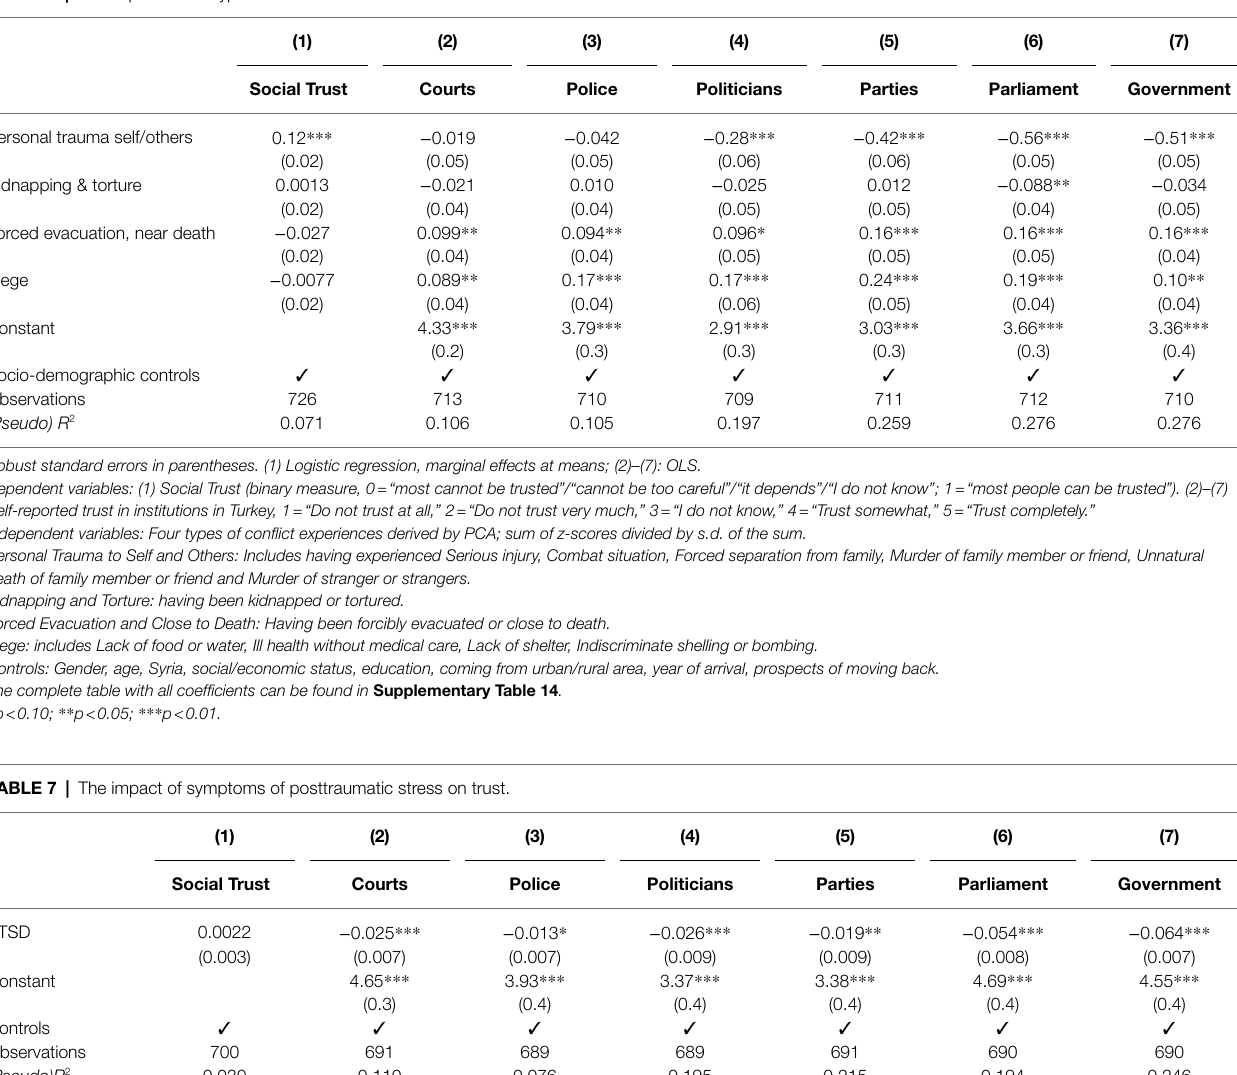
TABLE 6 | The impact of subtypes of traumatic events on trust.